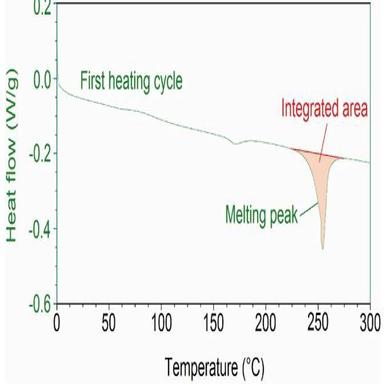
DSC curve of a semi-crystalline material (PET), first heating cycle, 5 �C/ min heating rate, 0–300 �C temperature range.